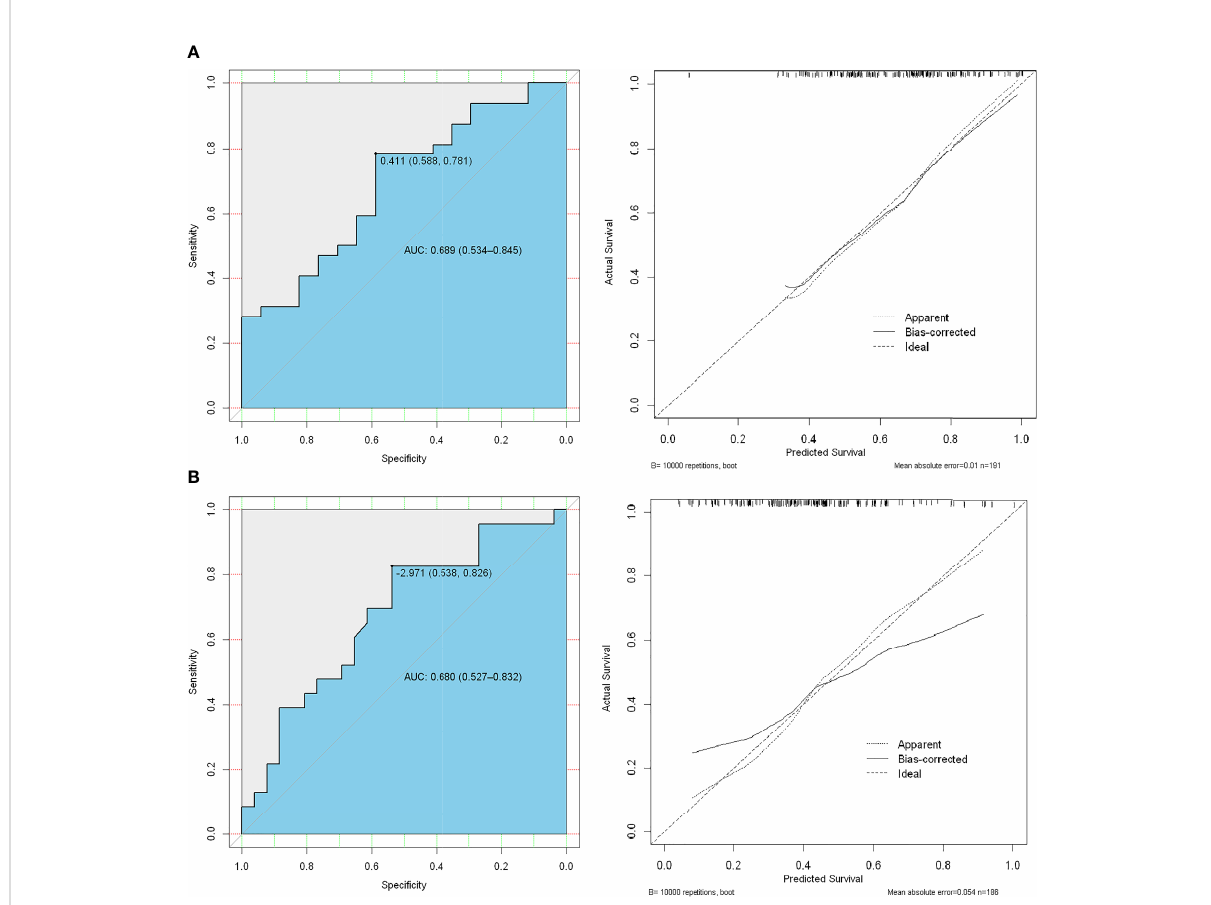
FIGURE 4 ROC analysis of the prediction model using high-risk Gleason score ( ≥ 8) vs. low-intermediate-risk Gleason score (<8) (A) , the fi rst line) and high-risk PSA level ( ≥ 20 ng/mL) vs. low-risk (<20 ng/mL) PSA level (B) , the second